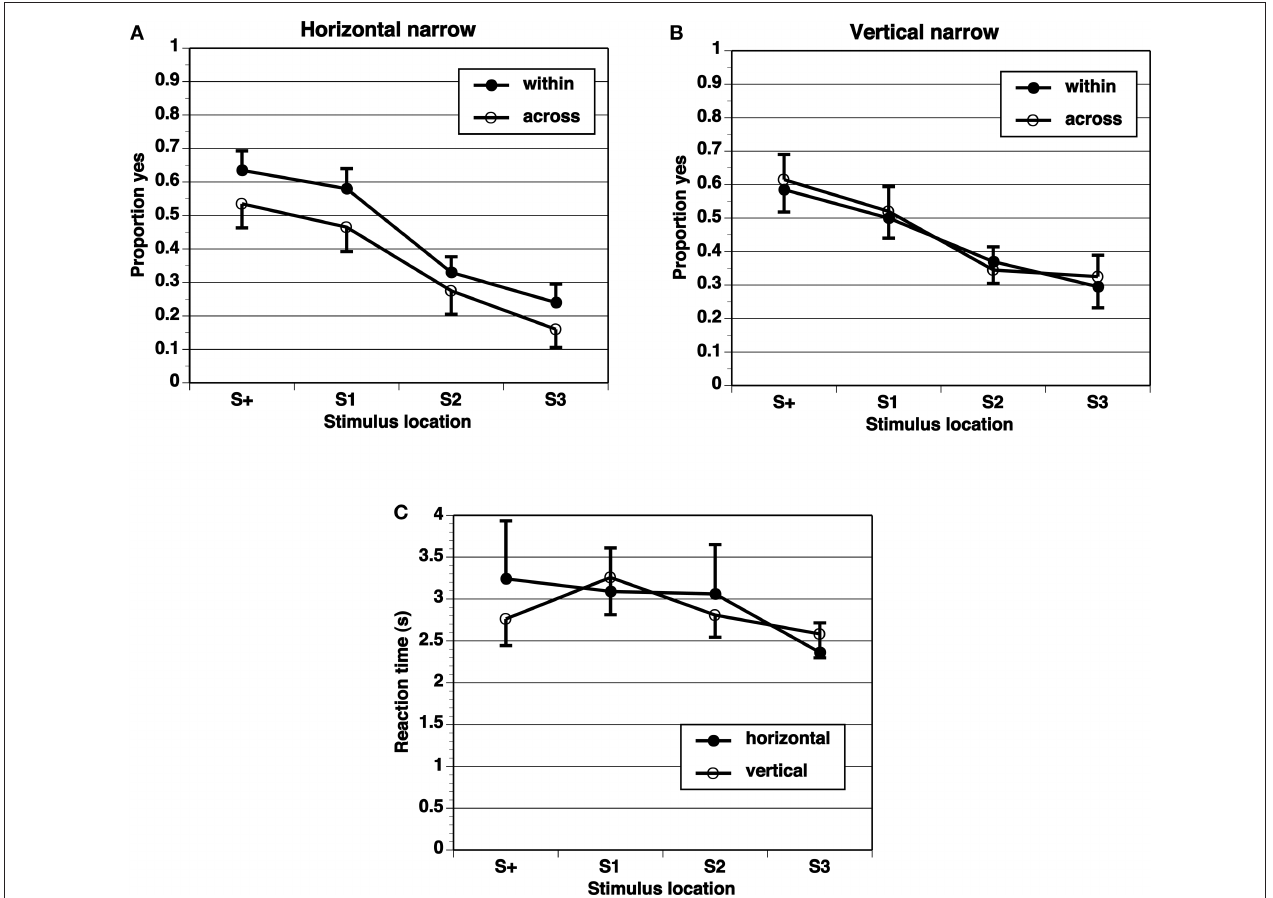
Figure 2 | Proportion of “yes” responses (A, B, M ± SeM) and reaction times (C, M ± SeM) in the Narrow-4 experiment, with narrow spacing between stimulus locations and four test